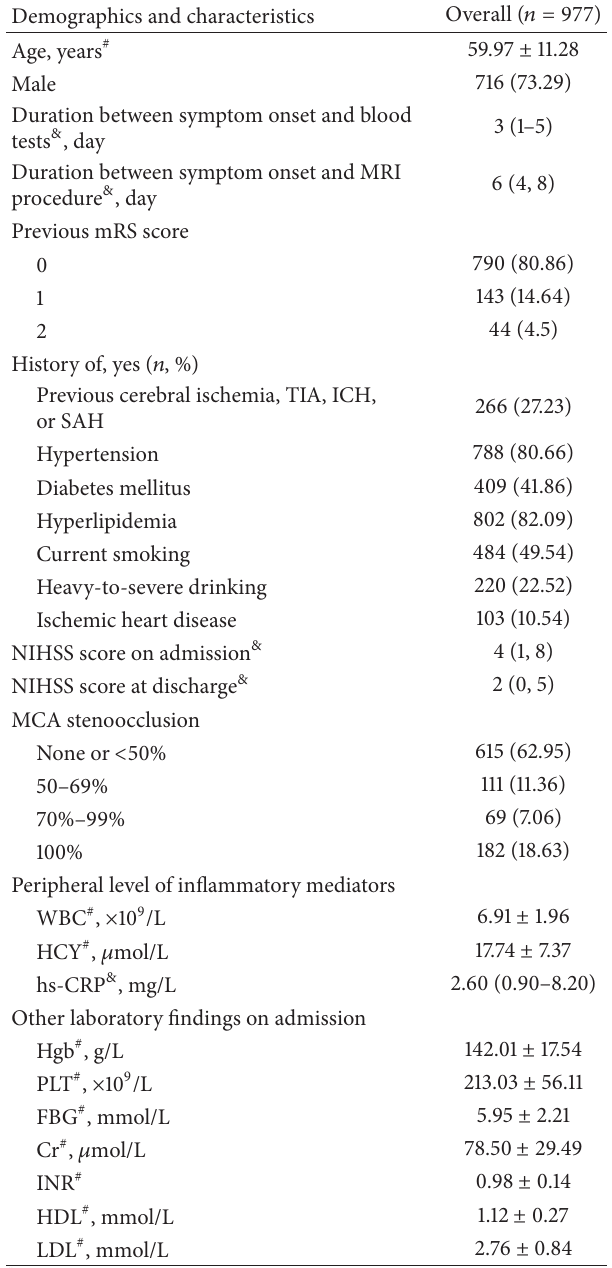
Table 1: Baseline characteristics of